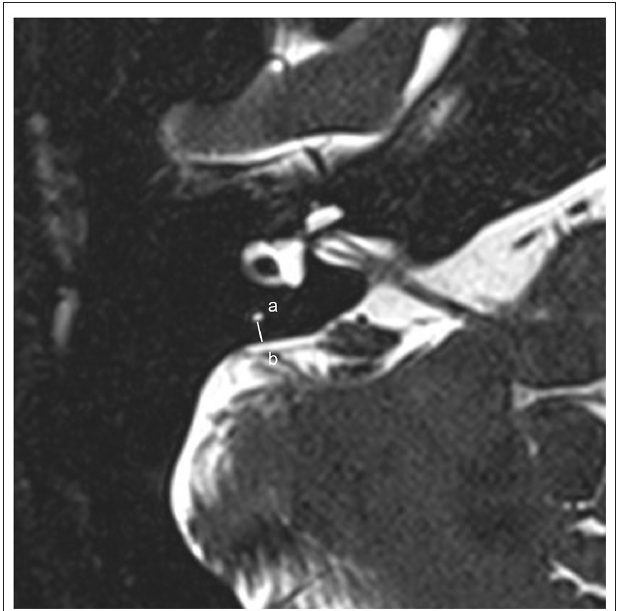
FIGURE 1 | A 0.5-mm axial 3D-SPACE MRI scan showing detailed image of the right ear at the level of the measured distance between the vertical part of the posterior semicircular canal (a) and the posterior fossa (b) . 3D-SPACE, three-dimensional sampling perfection with application optimized contrasts using different flip angle